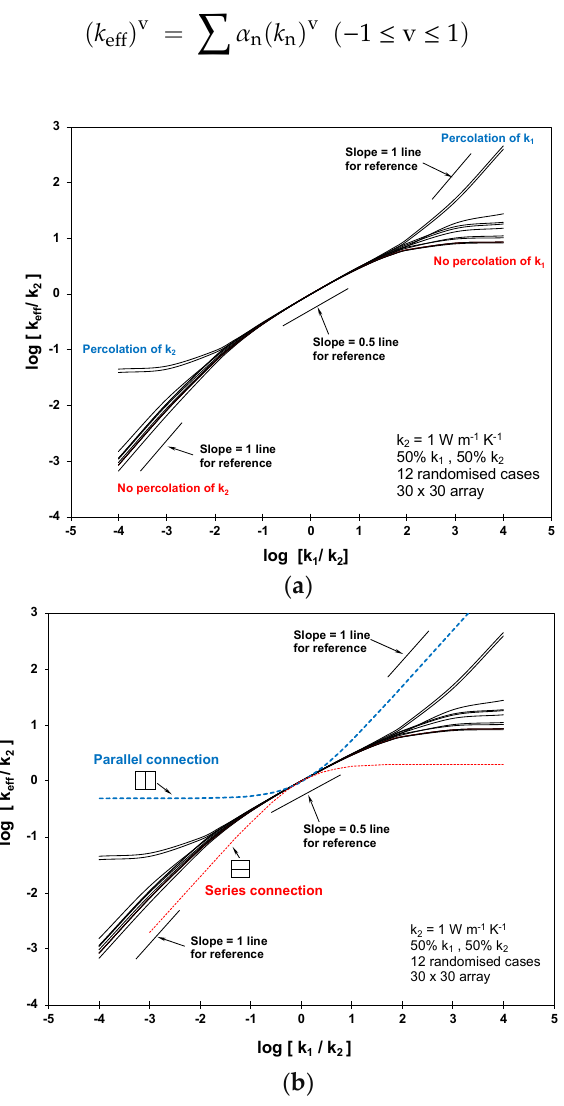
Figure 2. ( a ) Log-log plot of effective conductivity as a function of k 1 / k 2 for 12 different randomizations, each corresponding to a 30 × 30 system, where α 1 = 0.5. ( b ) Series and parallel bounds.